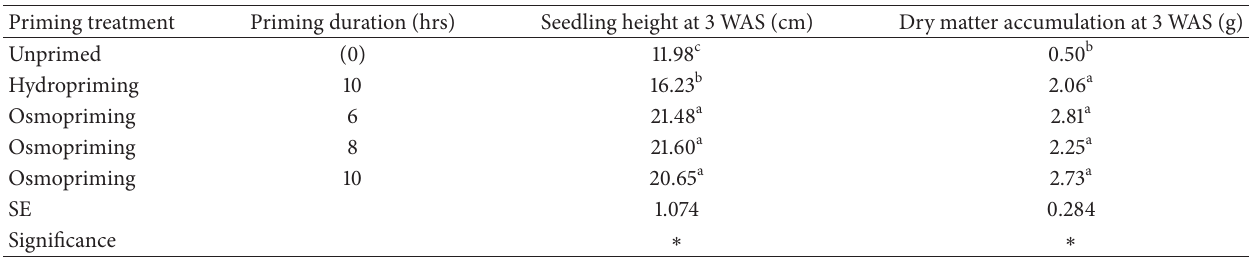
Table 3: Effect of osmopriming duration on the height and dry matter accumulation of cowpea seedling at 3 weeks after sowing. Priming